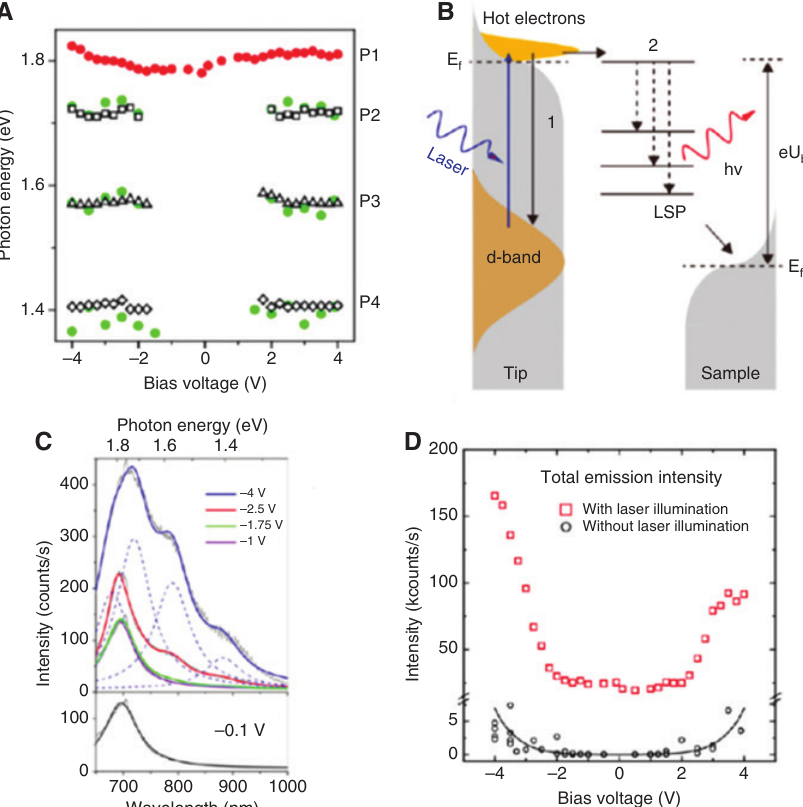
Figure 8: STM light emission spectroscopy on a bare Au-Au junction with and without additional laser pumping. (A) Peak positions of PL bands due to laser excited electron-hole combination (P1) and IET (P2, P3, and P4, black symbols). For comparison, the three radiative LSP modes (solid green circles) excited by pure IET in the junction without laser illumination are plotted as well. (B) Sketch of the processes involved in a biased Au-Au junction under laser illumination. Process (1) is related to electron-hole recombination and radiative inelastic plasmon relaxation. Process (2) is related to the radiative decay of LSP modes created by IET (C) PL spectra (gray lines) and the fitting curves (solid smooth lines) of the laser illuminated Au-Au junction. At low bias voltages | U | < 1.75 V, the spectral line shape consists of one band. As the negative bias voltage increases, LSPR modes appear. (D) Comparison of the spectrally integrated total PL intensities as a function of bias voltage from the irradiated Au-Au junction (open red squares) and from the non-irradiated junction (open circles), reprinted with permission from Ref. [37], copyright (2015) American Chemical